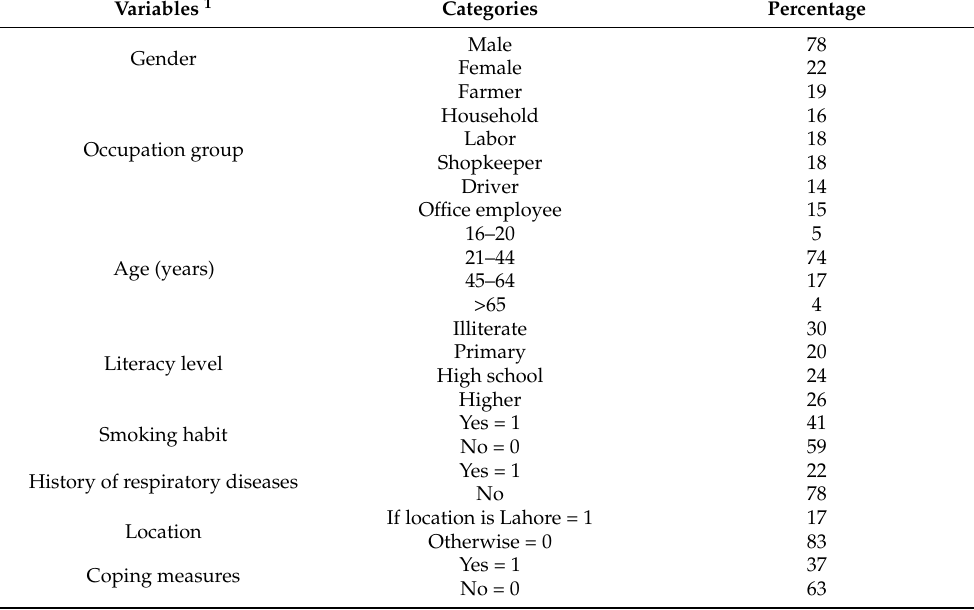
Table 2. Variables associated with determinants of health symptoms.